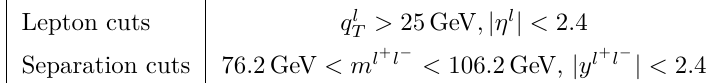
√ s = 13 TeV , see ref.